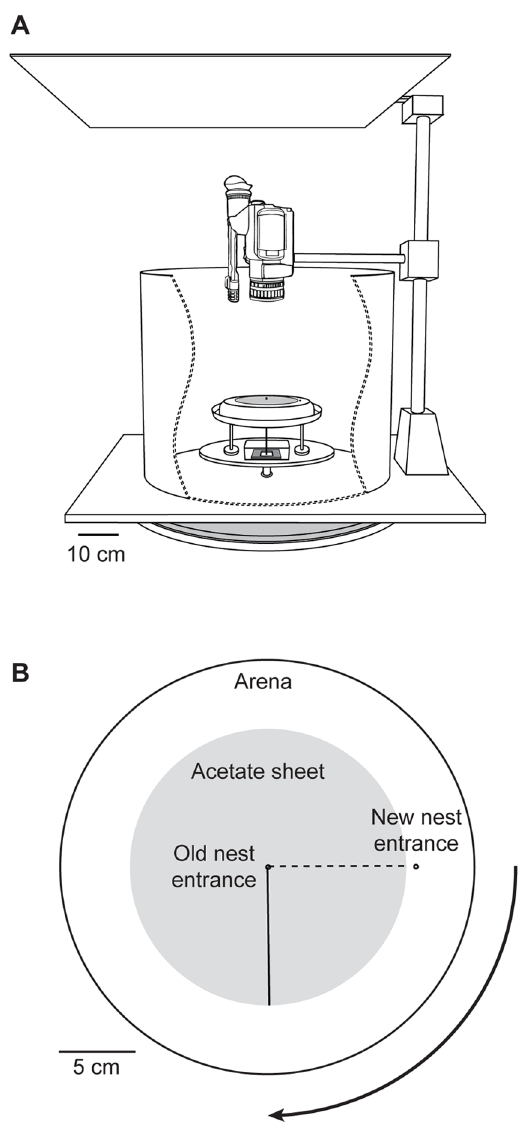
Figure 6. Apparatus for manipulation of visual cues during colony emigration. A) Side view shows the arena, old nest, and new nest arranged as in Figure 1, except that the arena was circular and designed to minimize visual cues (see Materials and Methods). The arena was centered in a cylinder with a complex visual scene displayed on its inner surface (partially cut away to show the arena). The cylinder rested on a copy stand that also carried a video camera and a screen to mask visual cues from the ceiling. The copy stand was mounted on a turntable so that it, along with the cylinder, camera, and screen, could be rotated around the stationary arena. B) Top view shows the arena floor. In the midst of each emigration, the copy stand was rotated 90 u clockwise. Emigrating ants were observed to determine if they continued to walk toward the new nest (dashed line) or shifted their headings to match the new position of the visual scene (solid line). An acetate sheet was placed on the arena floor for consistency with the substrate-cue experiments, but it was not